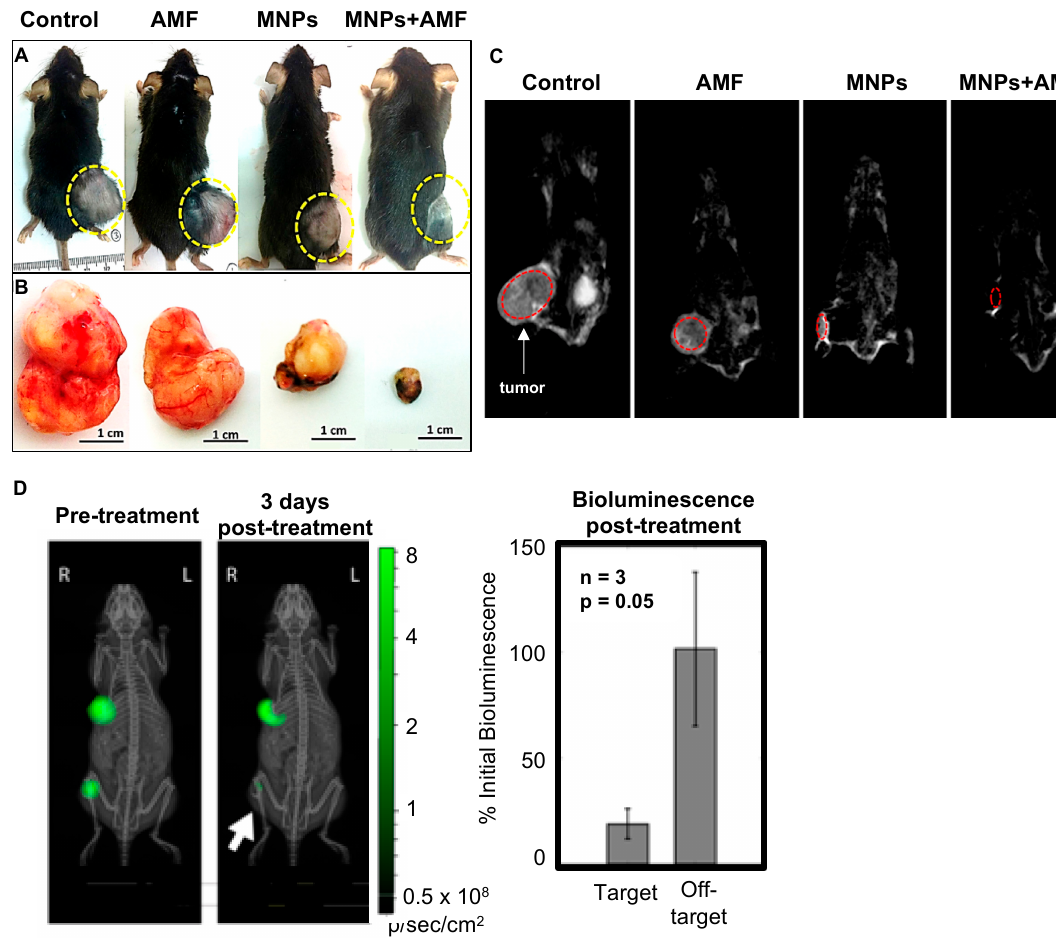
Figure 5. Strategies to evaluate heating effects in vivo. ( A ) Tumor volume in control and treated mice 30 days after treatment. ( B ) The tumors were excised from the animals for an easier-sized comparison. ( C ) Magnetic resonance imaging (MRI) also allows control of tumor size before and after treatment. Adapted with permission from Reference [23]. Copyright 2017 Elsevier. ( D ) Using luciferase-modified cell lines to generate the tumors, it is possible to track the bioluminescence signals and correlate them with tumor size. Adapted with permission from Reference [106]. Copyright 2018 American Chemical Society.